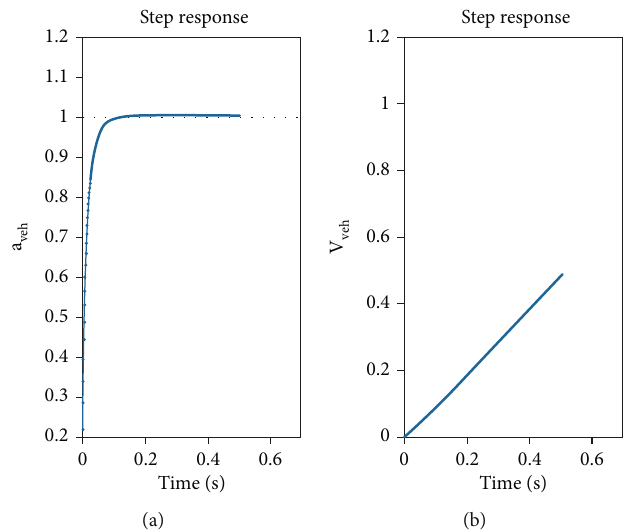
Figure 16: Vehicle acceleration (a) and speed (b) responses, respectively, in PID-CHR (3).